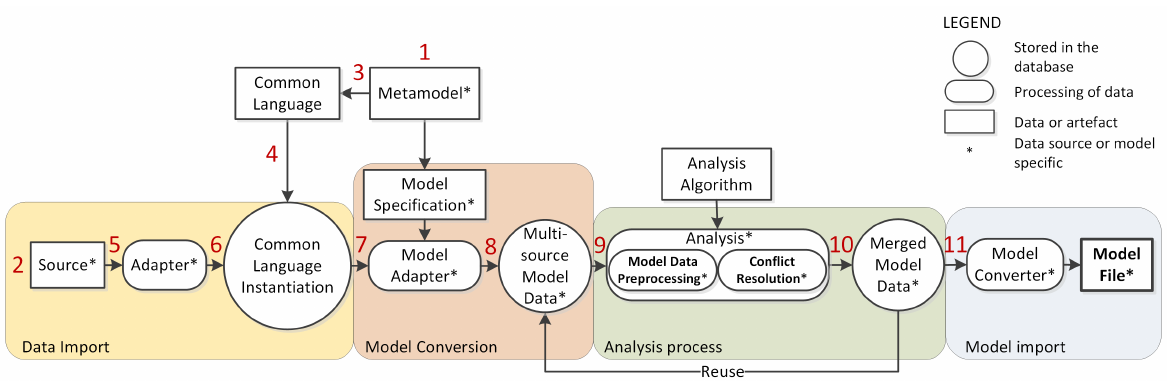
Figure 2. Overview of the general process that consists of eleven